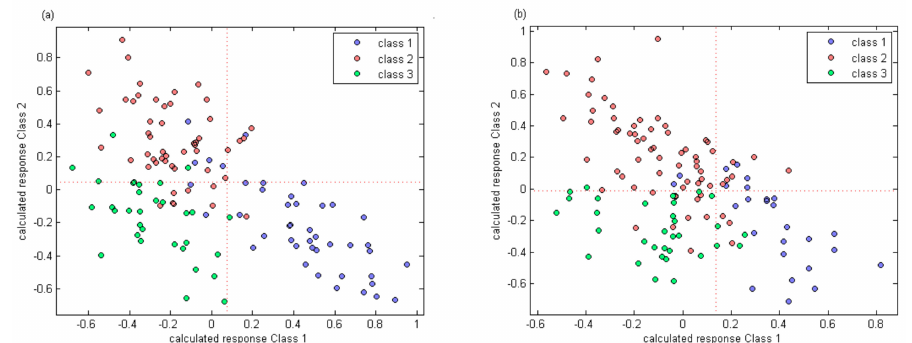
Figure 4. Calculated response of three classes using partial least squares discrimination analysis. ( a ) the calculated response of PLS-DA for Manicure Finger; ( b ) the calculated response of PLS-DA for Ugni